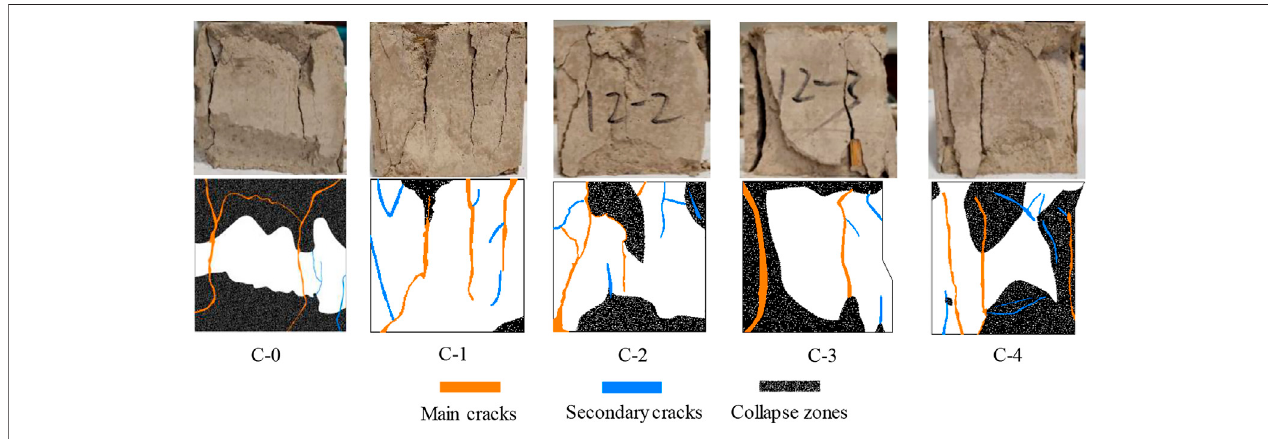
FIGURE 11 | Failure mode of CTB and